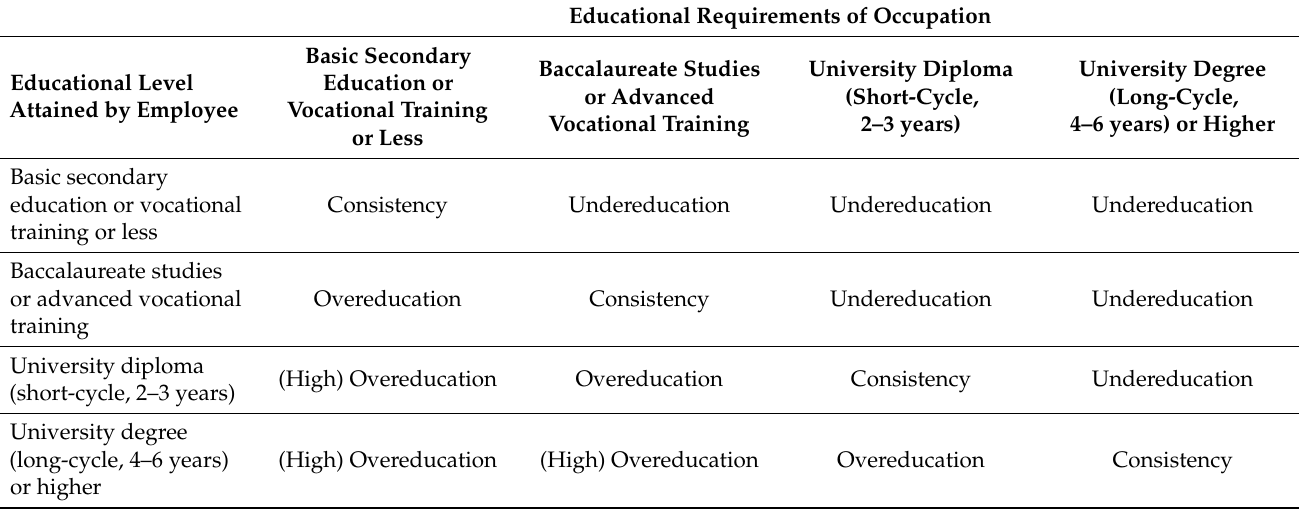
Table A1. Definition of education/employment mismatch